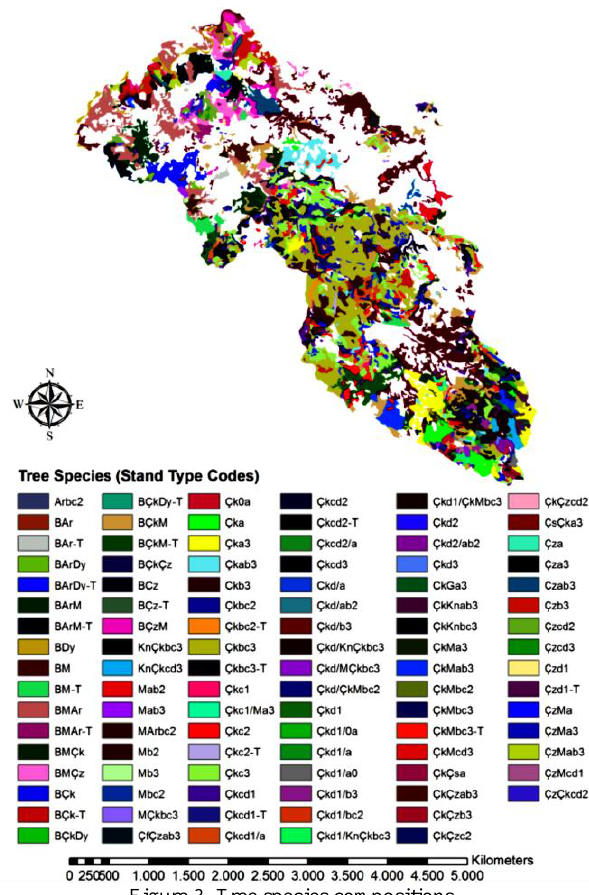
Figure 3. Tree species compositions